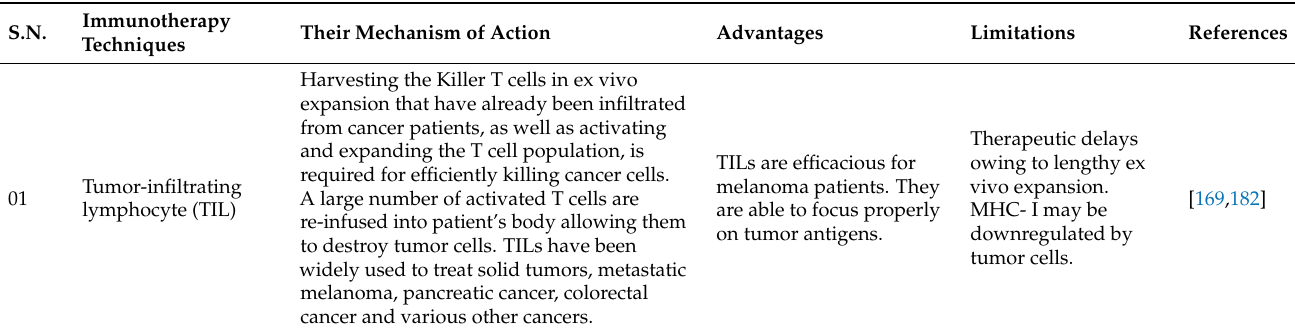
Table 3. The tabular representation of the current immunotherapy techniques that are used for cancer treatment